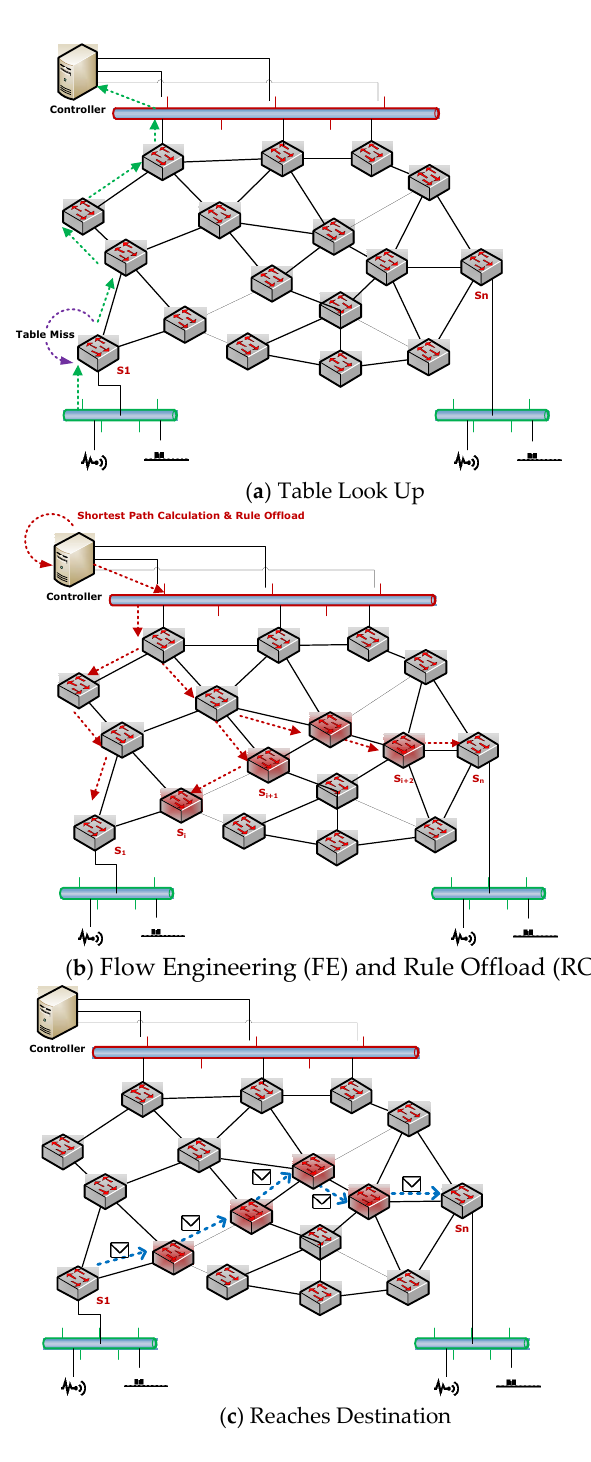
Figure 4. Working mechanism of HFIS (Hybrid Flow Installation Scheme). ( a ) Table Look Up; ( b ) Flow Engineering (FE) and Rule Offload (RO); ( c ) Reaches Destination.